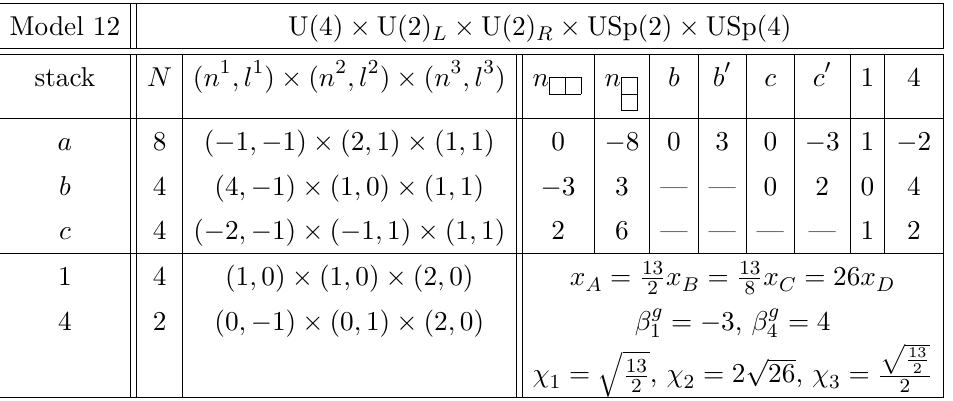
Table 19 . D6-brane configurations and intersection numbers of Model 12, and its MSSM gauge